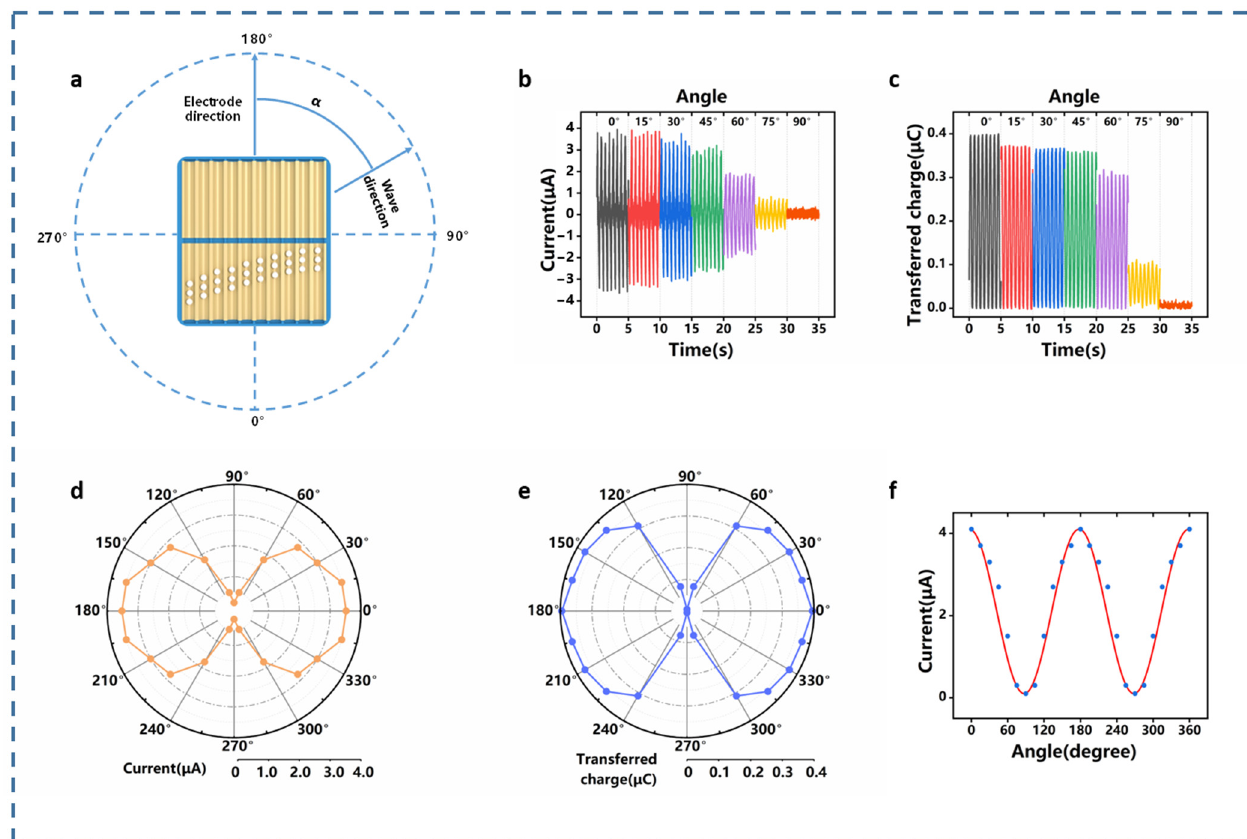
Figure 4. ( a ) The schematic diagram of the angle α between the electrode direction and wave direction. The short circuit current I sc ( b ) and transferred charge Q sc ( c ) measured under different angle α . The directional map of the ( d ) short circuit current, and ( e ) transferred charge. ( f ) Fitting curve of current output under different angles α .